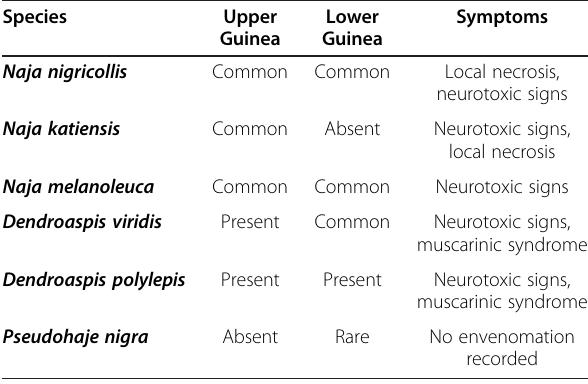
Table 6 Elapid species and distribution in Upper and Lower Guinea Species Upper